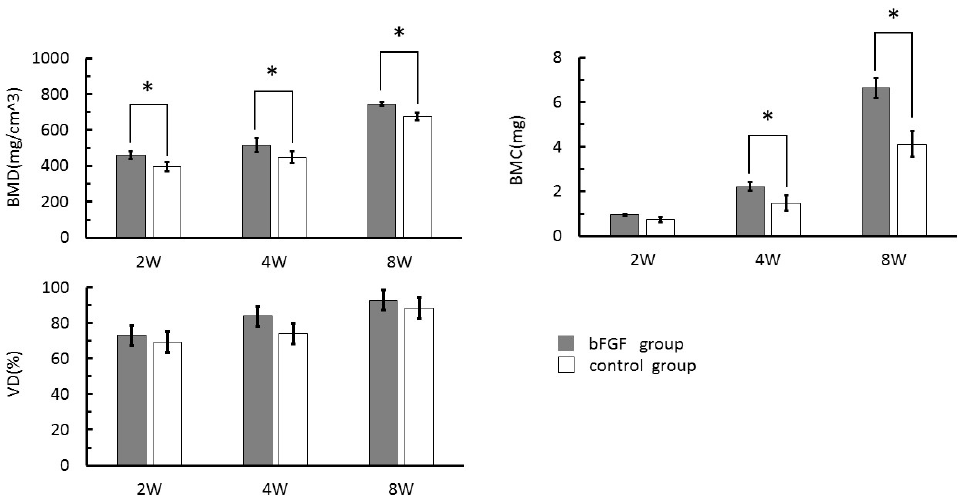
Figure 4. BMD, bone mineral content (BMC), and volumetric density (VD) in the bFGF and control groups at two, four and eight weeks. * p < 0.05.